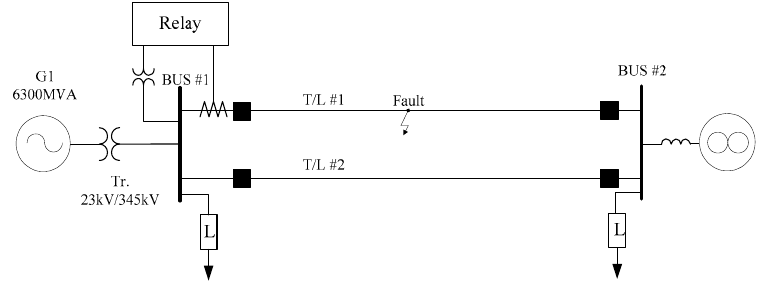
Figure 8. Test model of the power